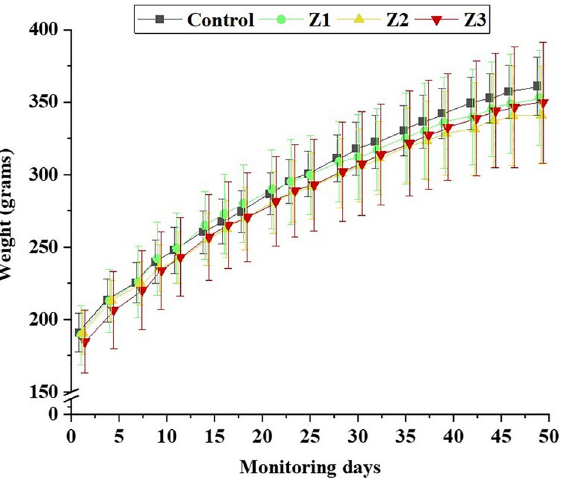
Figure 2. Weight of rats throughout the evaluation period. Z1 = low intensity training group; Z2 = moderate intensity training group; Z3 = high intensity training